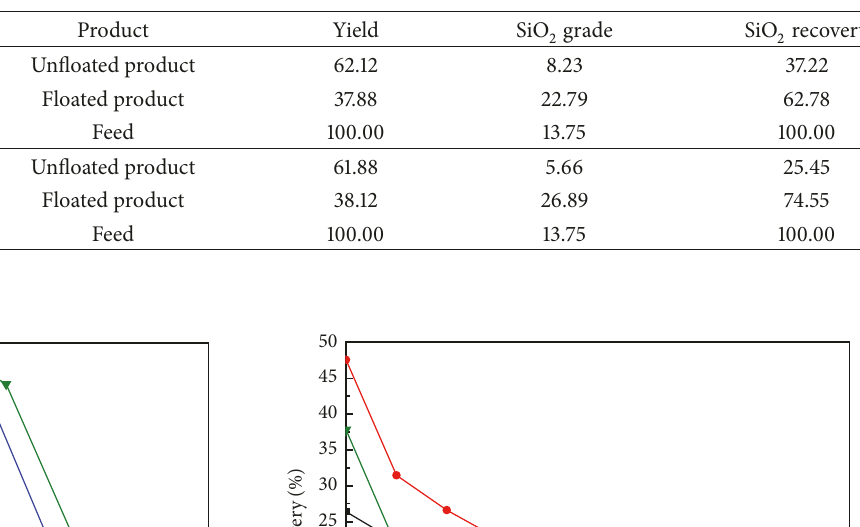
Table 2: Results of flotation separation of chlorite-hematite manual mixture mineral at pH 10/% {𝑐 (CaCl 2 ) = 100 mg/L and 𝑐 (CS) = 20 mg/L } .